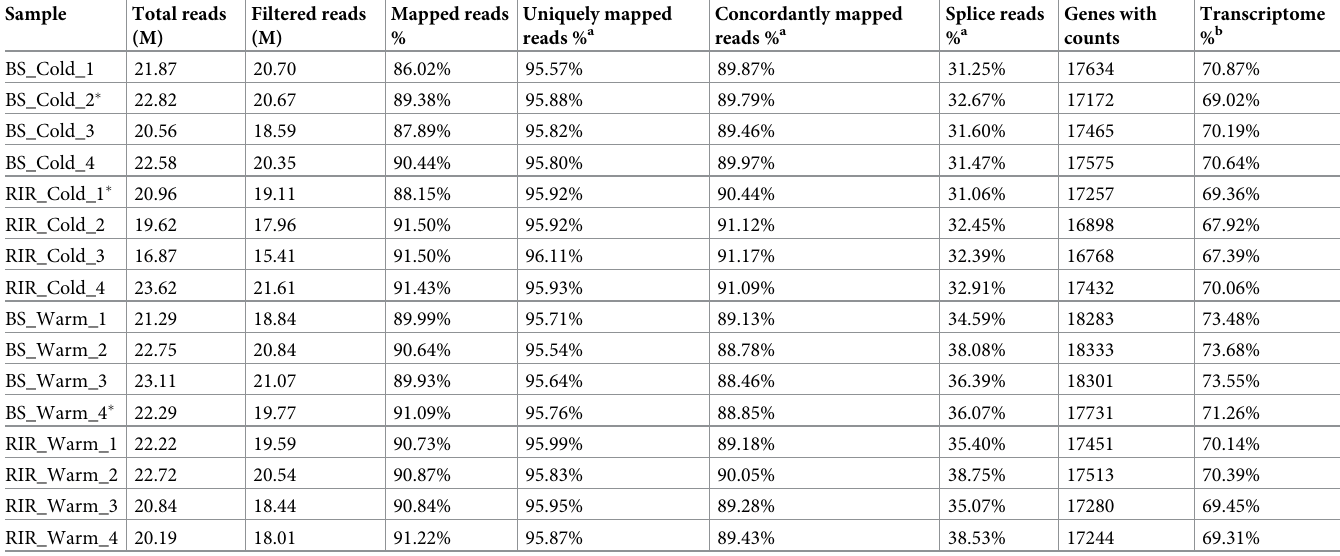
Table 2. Statistics for the filtering and mapping of